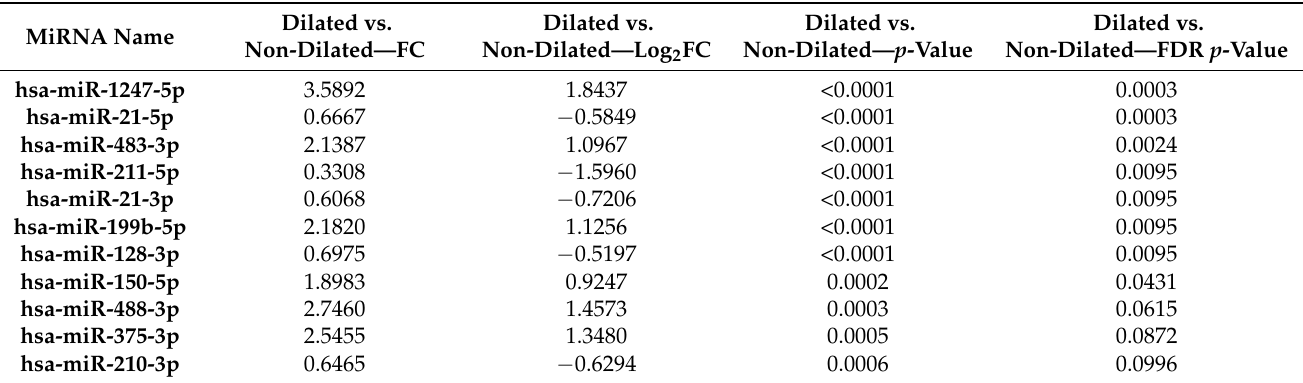
Table 2. Next-generation sequencing chosen targets for miRCURY LNA assay validation.